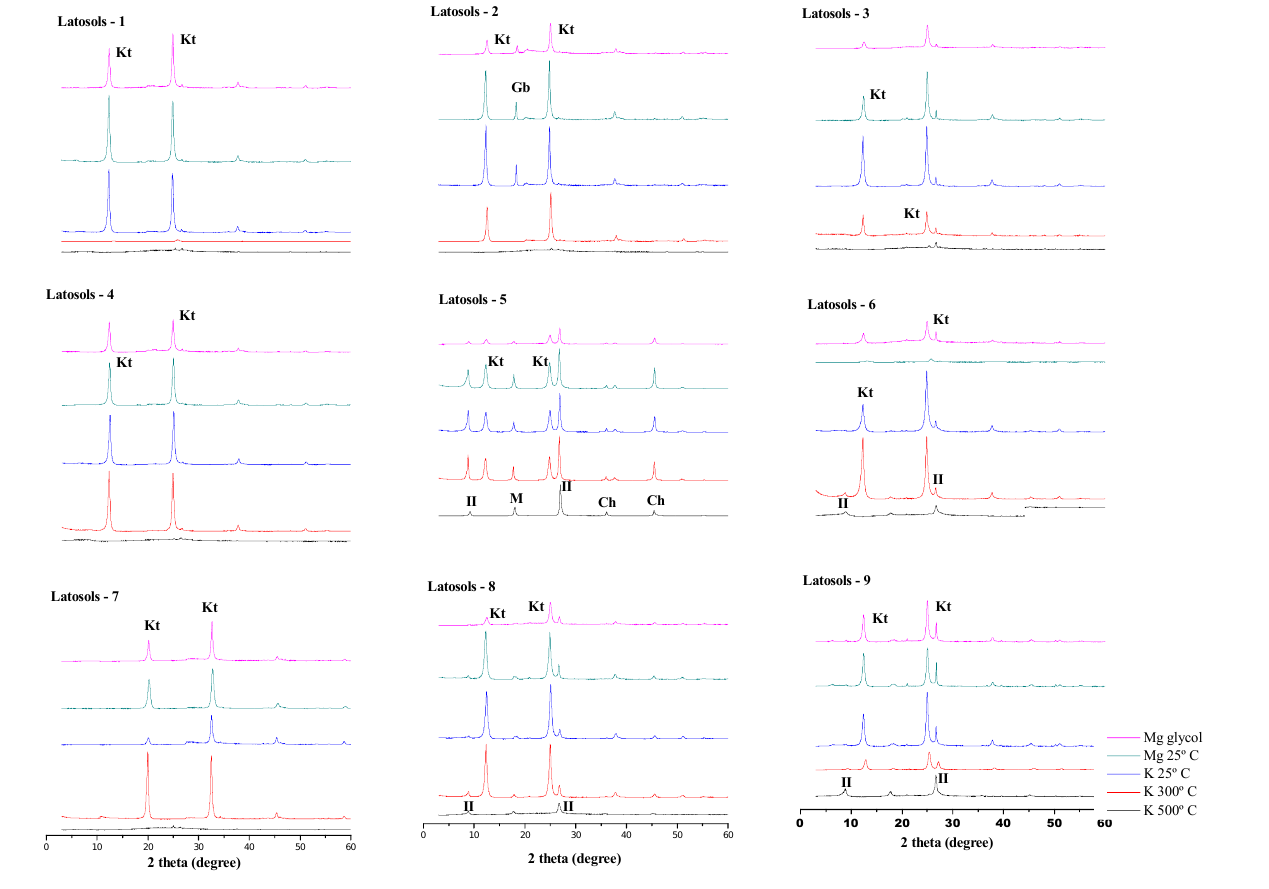
Figure 7. X-ray diffractograms in Latosols of the state of Pará.